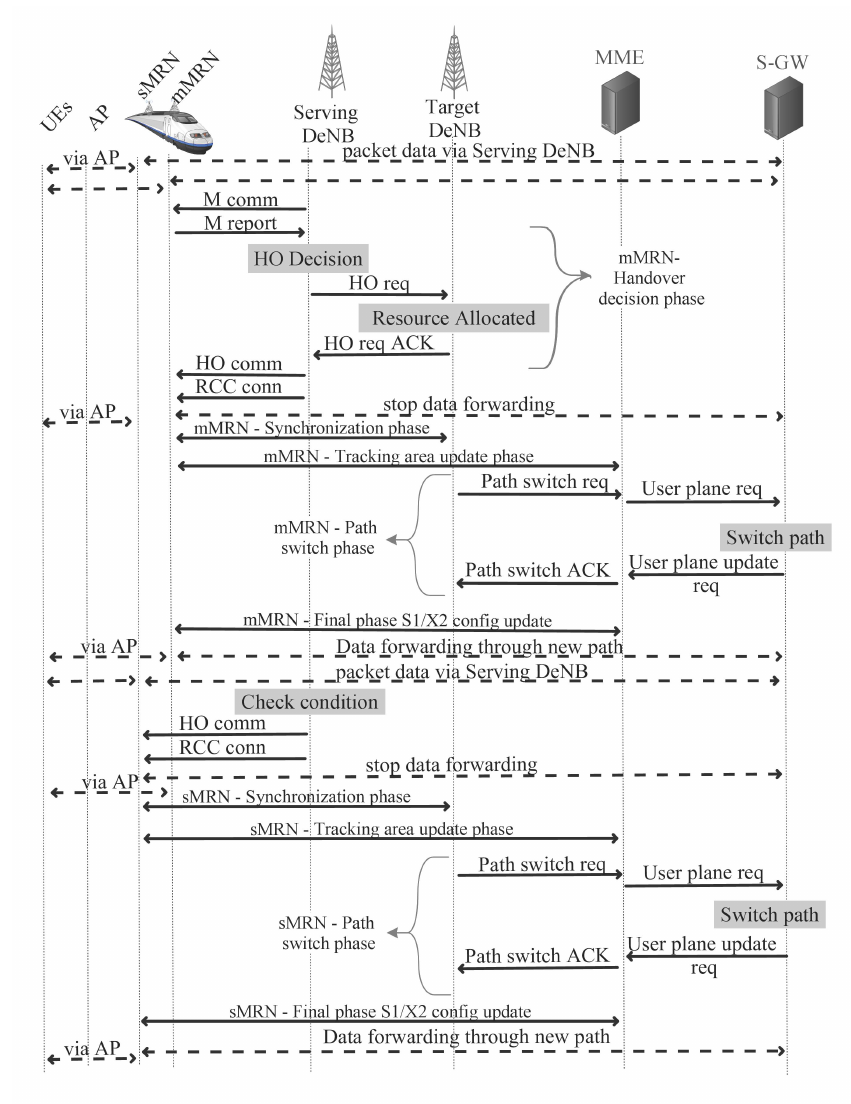
Figure 10. Flowchart of the proposed HO scheme for dual